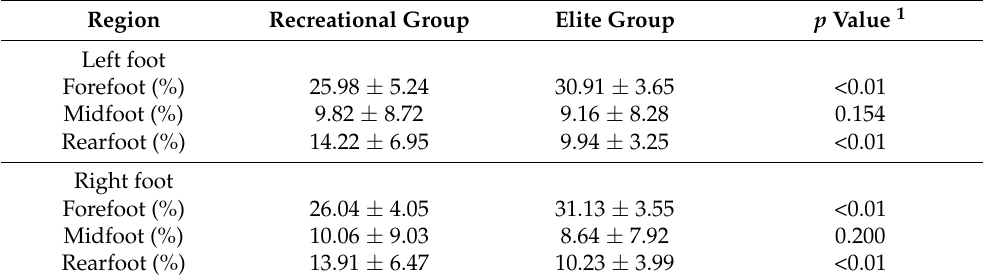
Table 4. Relative Load of the Forefoot, Midfoot, and Rearfoot Regions During the Midstance Phase of